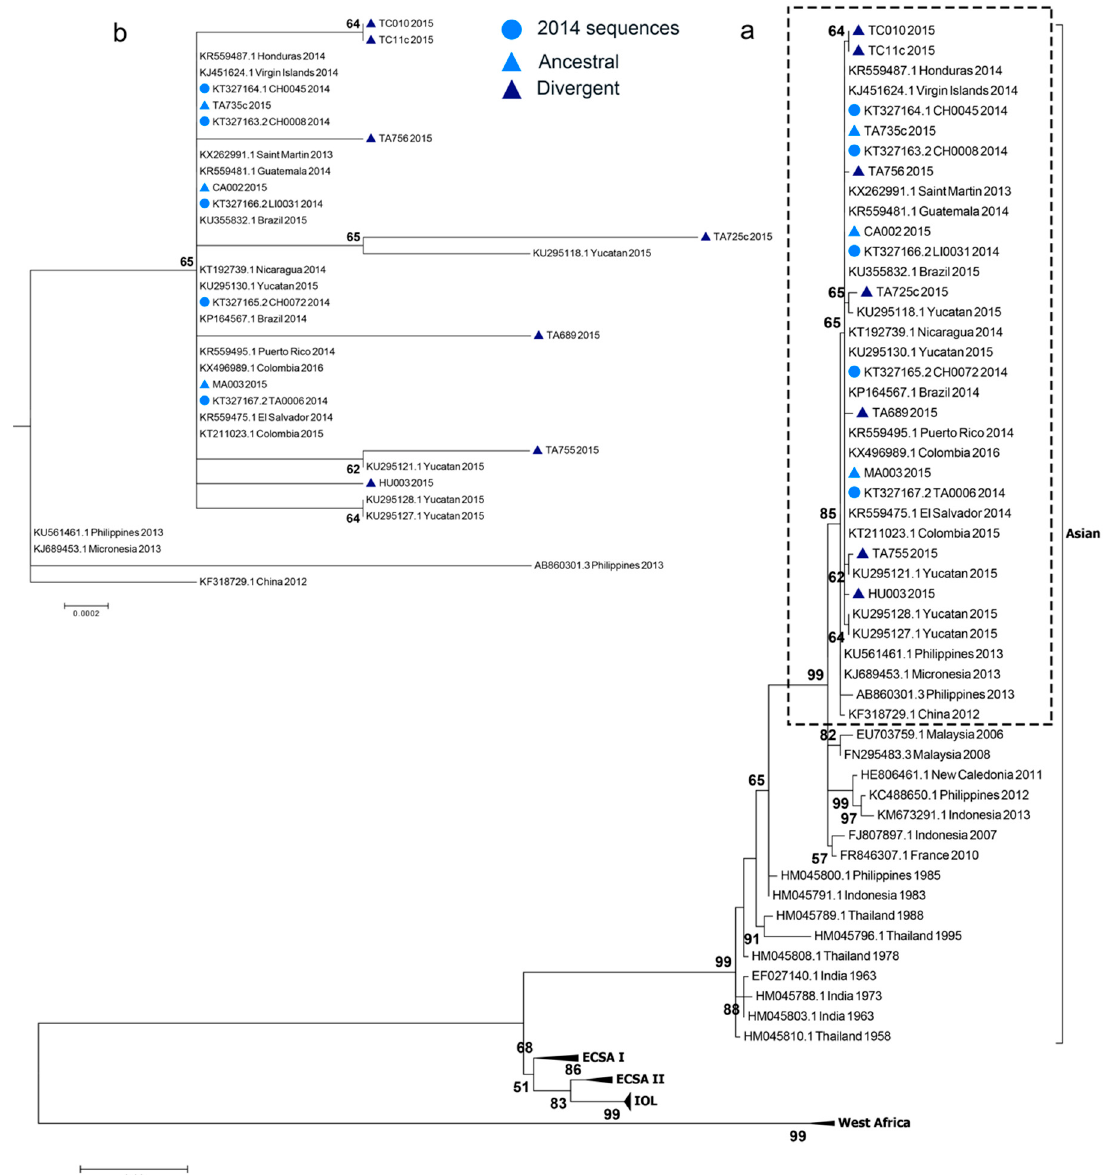
Figure 3. Maximum Likelihood phylogeny based on the E1 gene of 73 CHIKV sequences. The four CHIKV lineages are shown. Bold numbers at nodes correspond to the bootstrap value. Only bootstrap values above 50 are shown. The tree is drawn to scale, with branch lengths measured in the number of substitutions per site. ( a ) Strains isolated from Tapachula, Chiapas, 2015 belong to the Asian lineage. ( b ) Magnification of the discontinue box in ( a ), that shows the relationship of the newly and previously [42] sequenced strains. Sequences that were identical to the previously reported were considered ancestral, the others were considered divergent. The previously sequenced strains are indicated with a circle. The newly sequenced strains are indicated with a triangle. The triangles of the divergent sequences are darker.